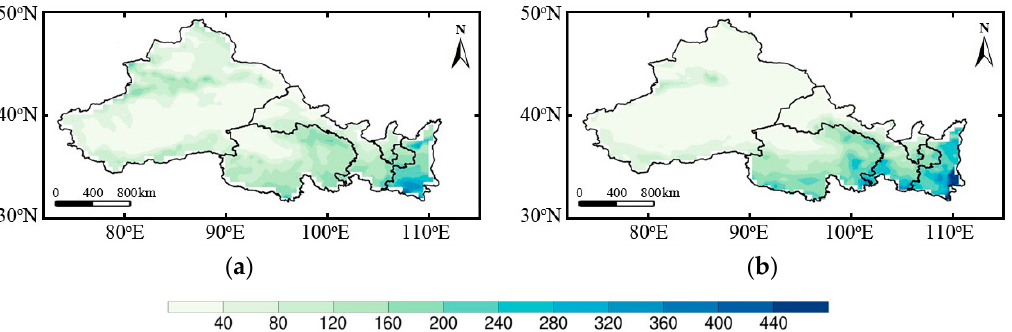
Figure 8. Spatial distribution of extreme heavy precipitation over Northwest China during 1961–2014: observations ( a ) and the values simulated by the BCC-CSM2-HR ( b ). Unit: mm.